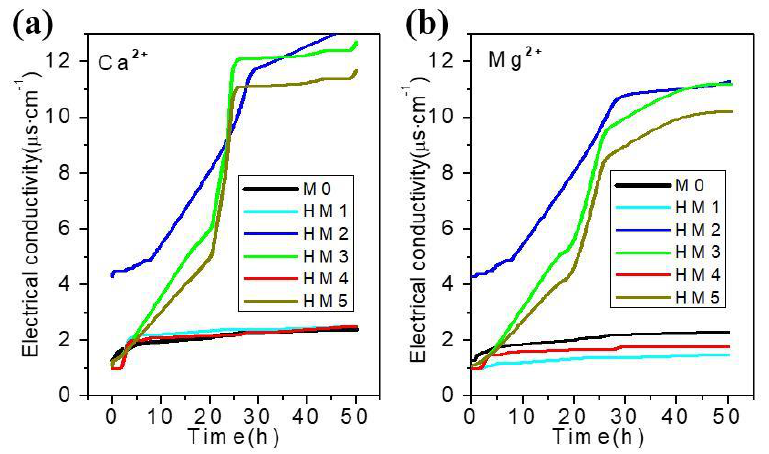
Figure 8. Electrical conductivity of Ca 2+ ( a ) and Mg 2+ ( b ) in blank membrane (M0) and organic– inorganic hybrid ion channel membranes (HM1–HM5) as a function of time.